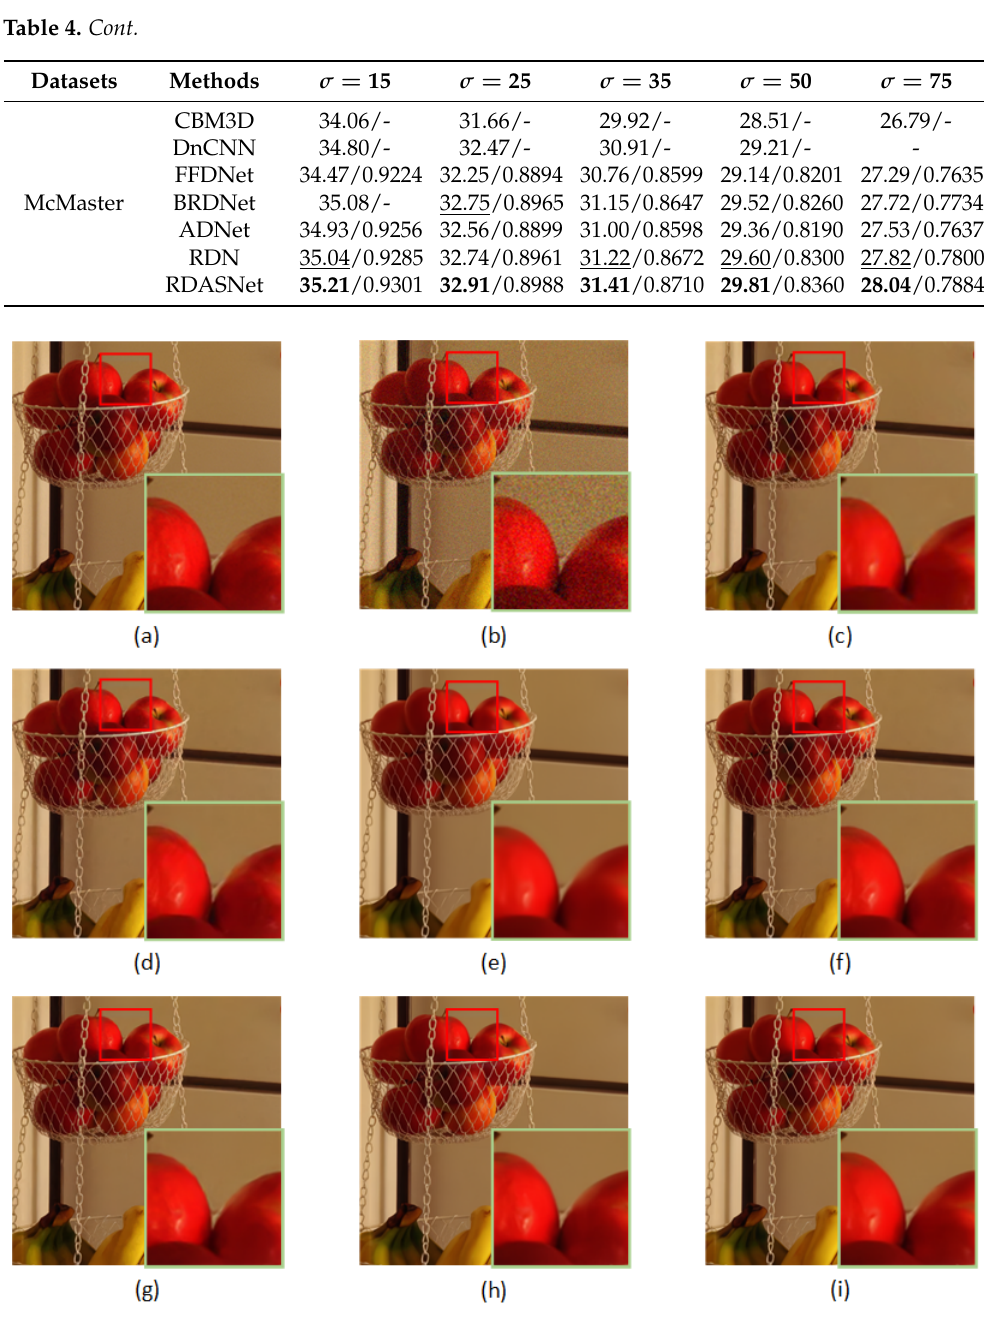
Figure 8. Denoising results of different methods on one image from McMaster with noise level σ = 15: ( a ) original image, ( b ) noisy image, ( c ) CBM3D/35.49 dB, ( d ) DnCNN/35.63 dB, ( e ) FFDNet/36.64 dB, ( f ) BRDNet/37.20 dB, ( g ) ADNet/36.59 dB, ( h ) RDN/37.20 dB, and ( i ) RDASNet/37.39